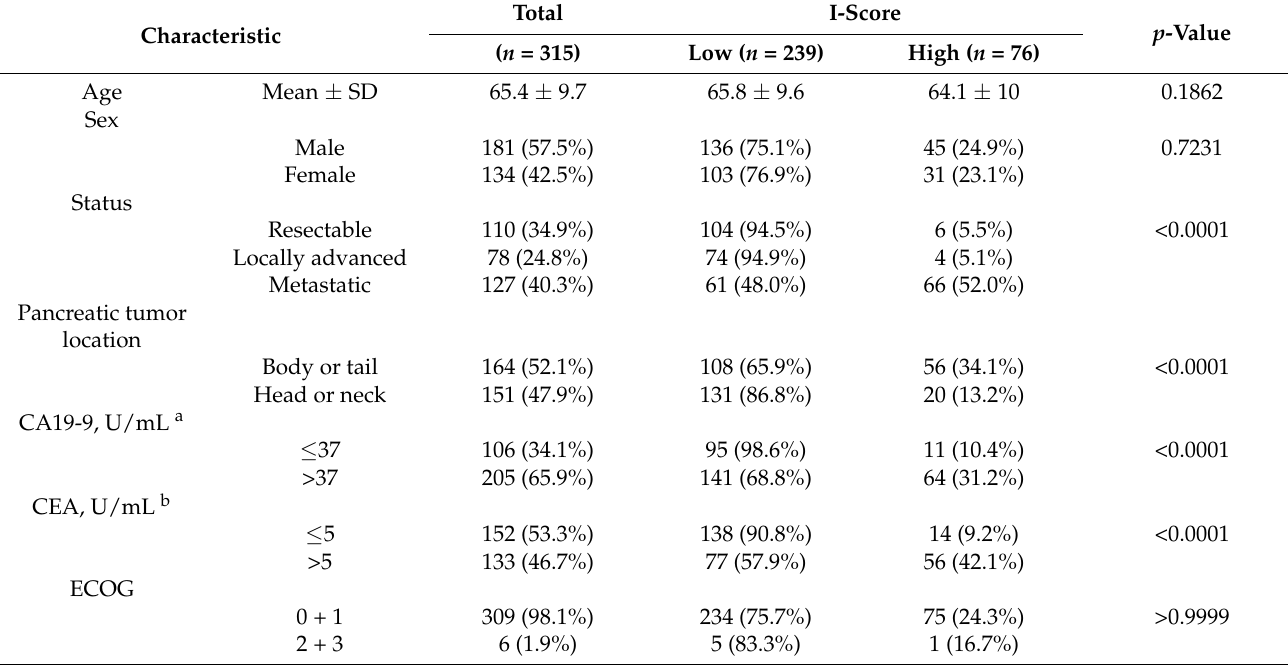
Table 1. Clinico-pathological characteristics of 315 pancreatic cancer patients stratified by I-score (high vs. low).